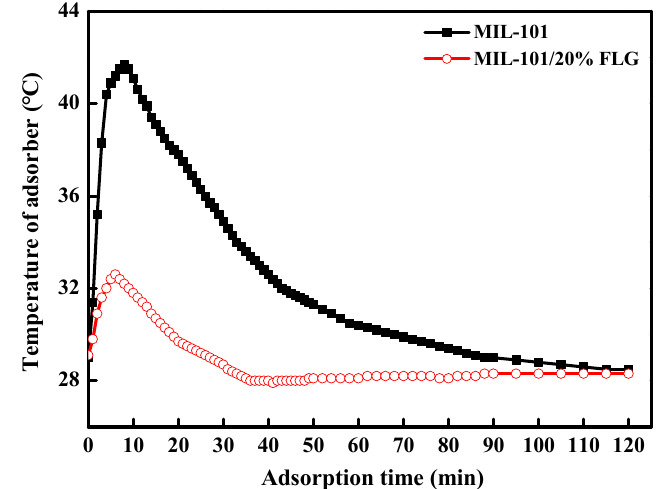
Figure 4. Temperature characteristic curves of MIL-101/20%FLG and MIL-101 adsorbers during the adsorption process.